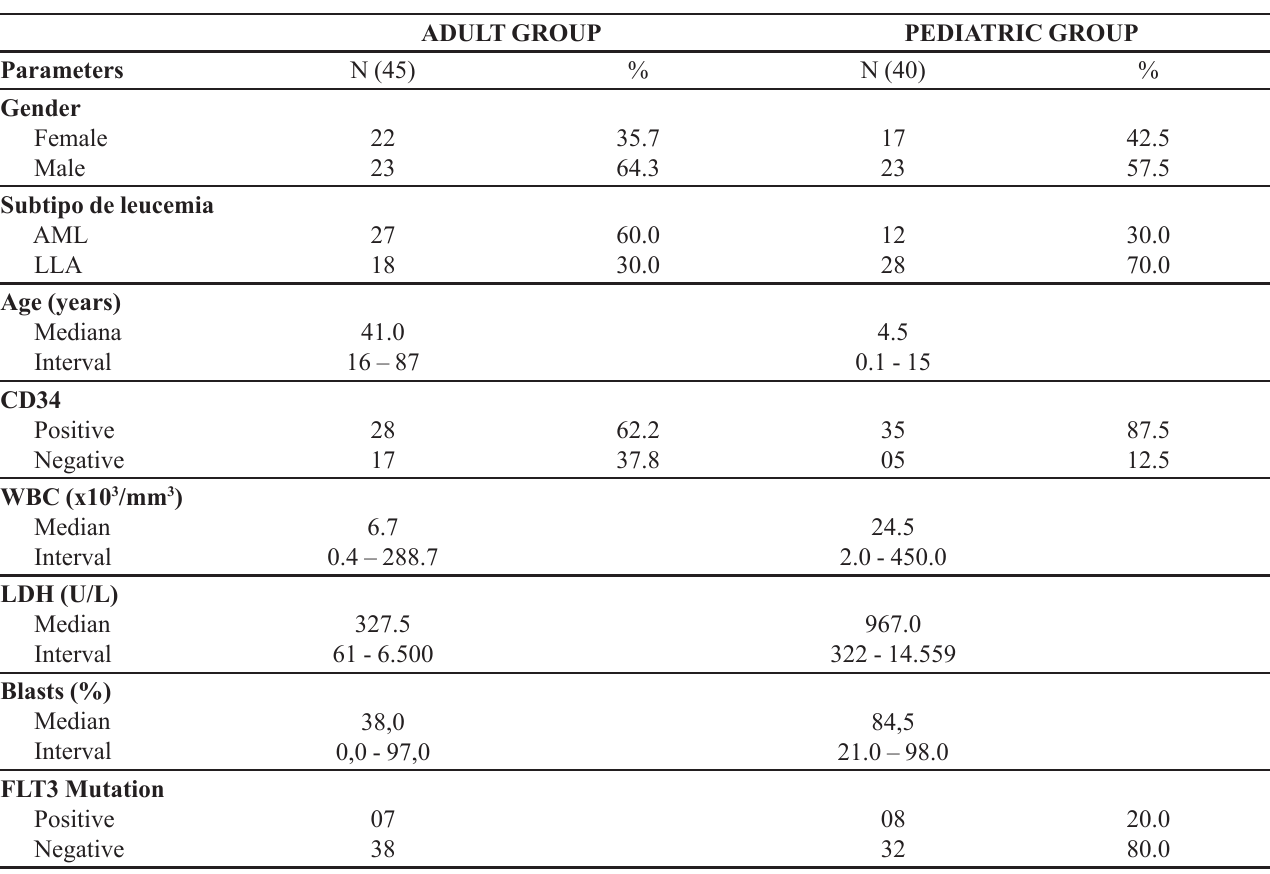
TABLE I - Clinical and laboratory characteristics of patients diagnosed with LA at the time of diagnosis ADULT GROUP PEDIATRIC